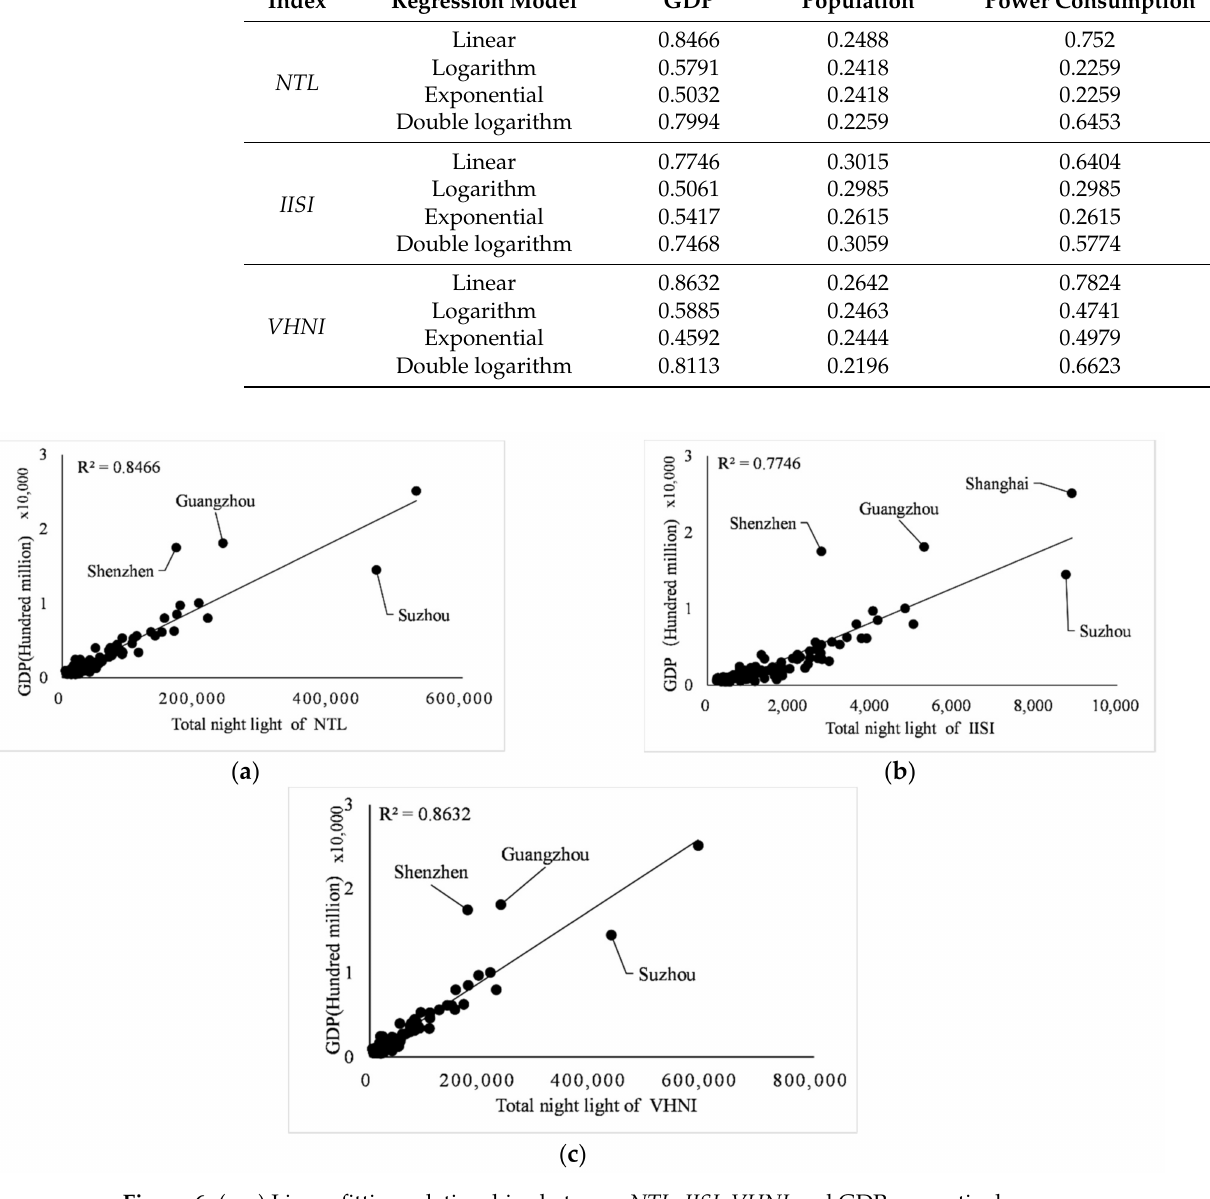
Figure 6. ( a – c ) Linear fitting relationships between NTL , IISI , VHNI and GDP,